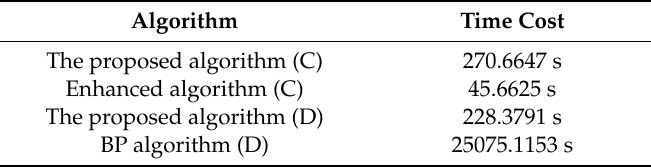
Table 5. Comparison on time cost of di ff erent algorithms for experimental